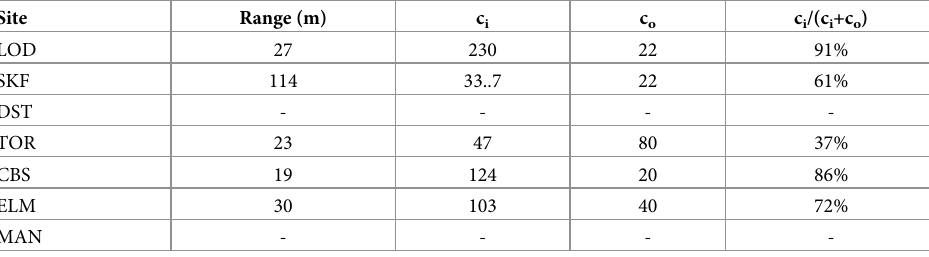
Table 3. Variogram parameters for the seven sites. Site Range (m) c i c o c i /(c i +c o ) LOD 27 230 22 91% SKF 114 33..7 22 61% DST - - - - 47 80 37% 86% 72% MAN - - - -